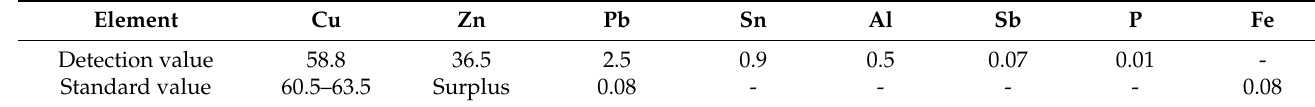
Table 1. Chemical analysis of failed clamp